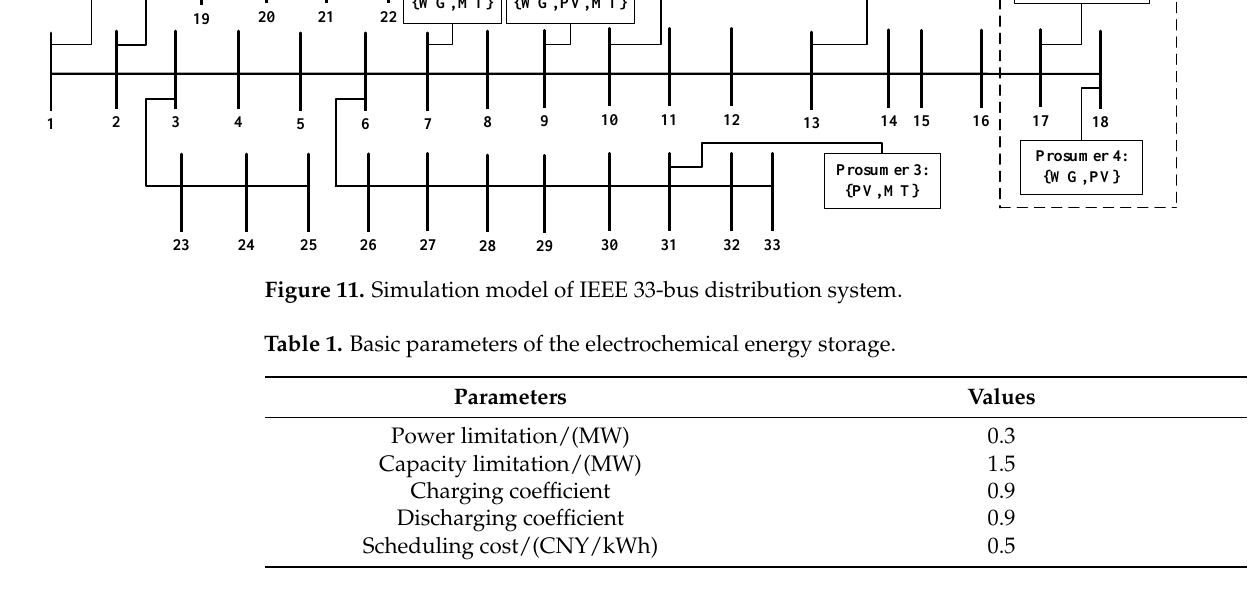
Table 2. Basic parameters of the micro gas turbine.